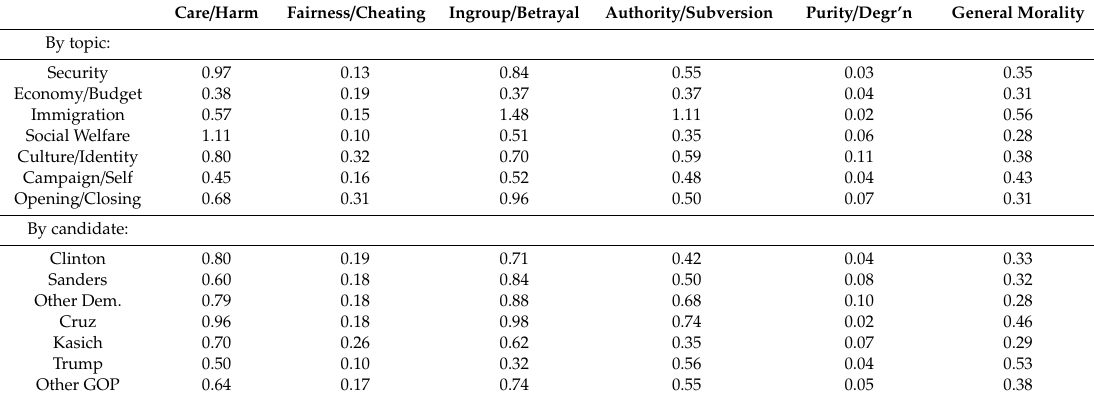
Table 3. Mean usage of morality words, per segment (as % of